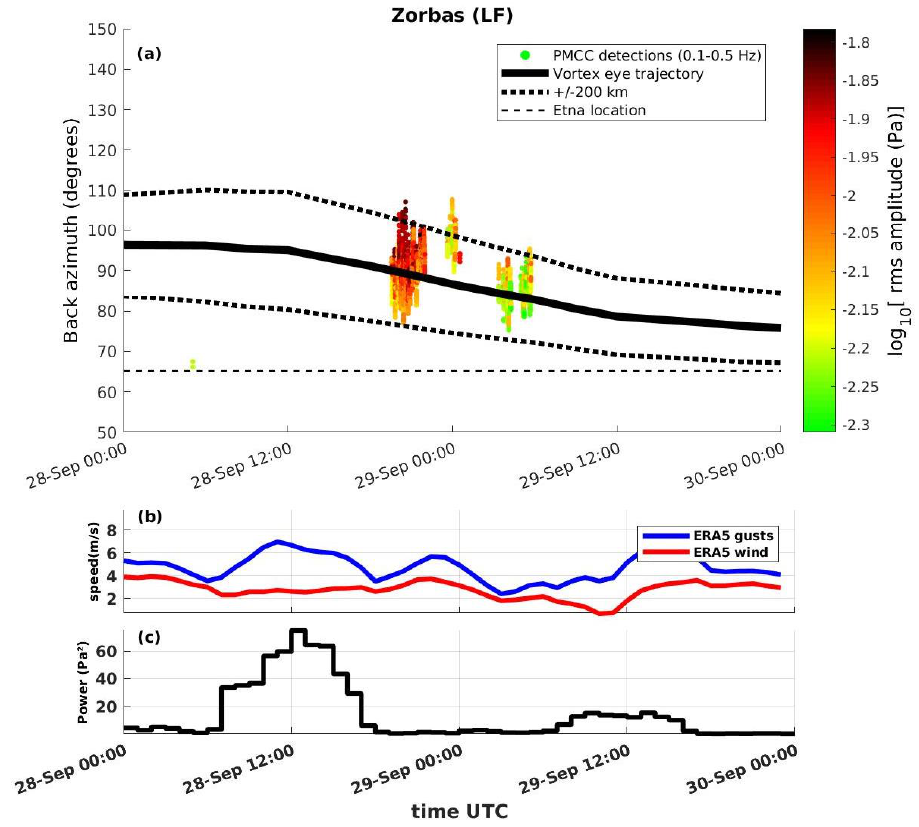
Figure 8. As in Figure 6, but for the Medicane Zorbas and in the 0.1 – 0.5 Hz range. The bottom plots showing the winds ( b ) and the proxy for wind noise ( c ) are the same as in Figure 3 or Figure 4.